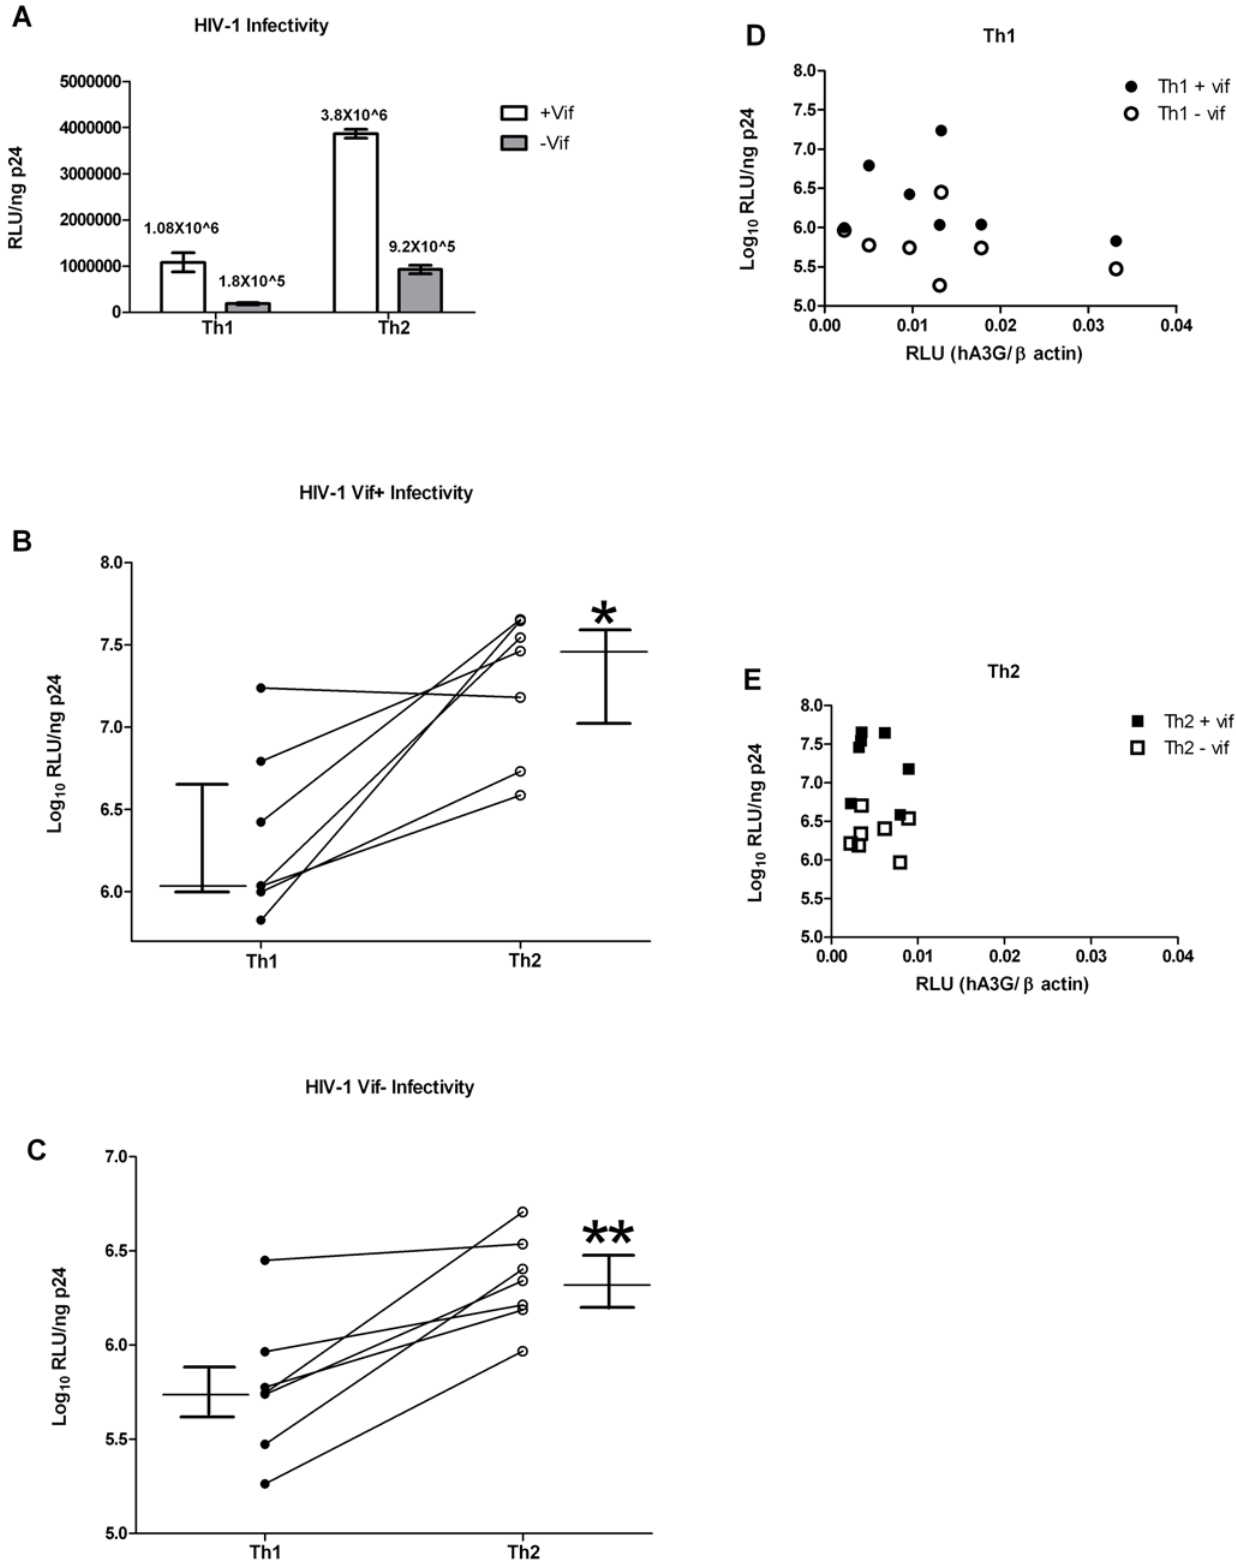
Figure 4. Increased Infectivity of HIV-1 produced from Th2 cells compared to Th1 cells. vif -competent ( + ) or vif -deleted ( 2 ) HIV-1(NL4-3) was used to infect cultures of Th1 and Th2 cells as described in Materials and Methods. Infectivity of the virions produced was determined by infection of the TZM-bl indicator cell line and determination of luciferase activity. An example from an individual donor is shown (A). The experiment was repeated on a total of seven donors with both the vif -competent (B) and vif -deleted virus(C). Error bars represent median and interquartile range